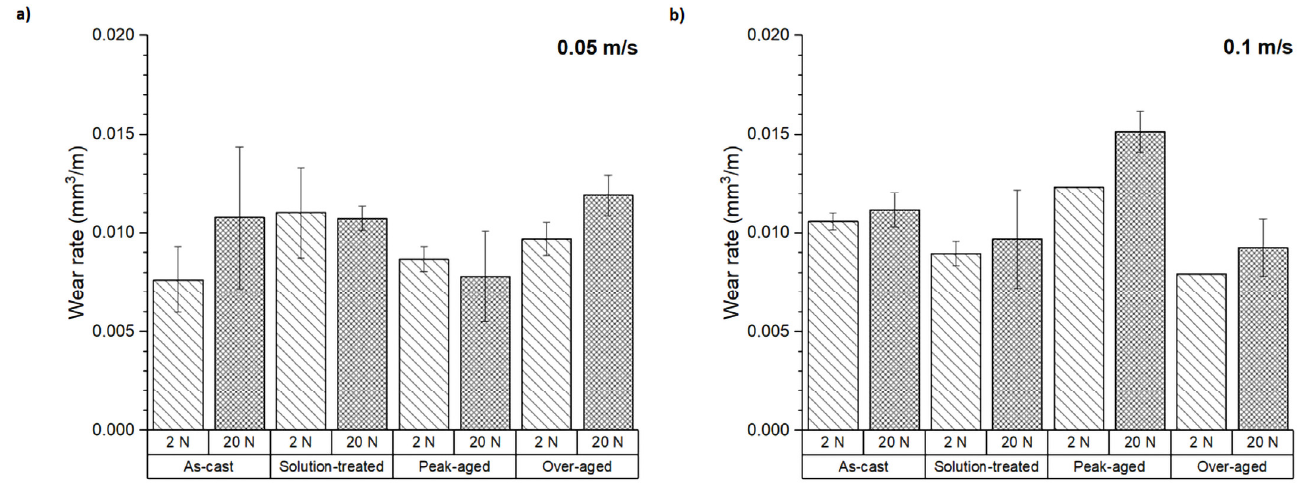
Figure 3. Wear rate of the ZX30 alloy applying 2 N and 20 N loads at sliding speeds of ( a ) 0.05 m s − 1 and ( b ) 0.1 m s − 1 .